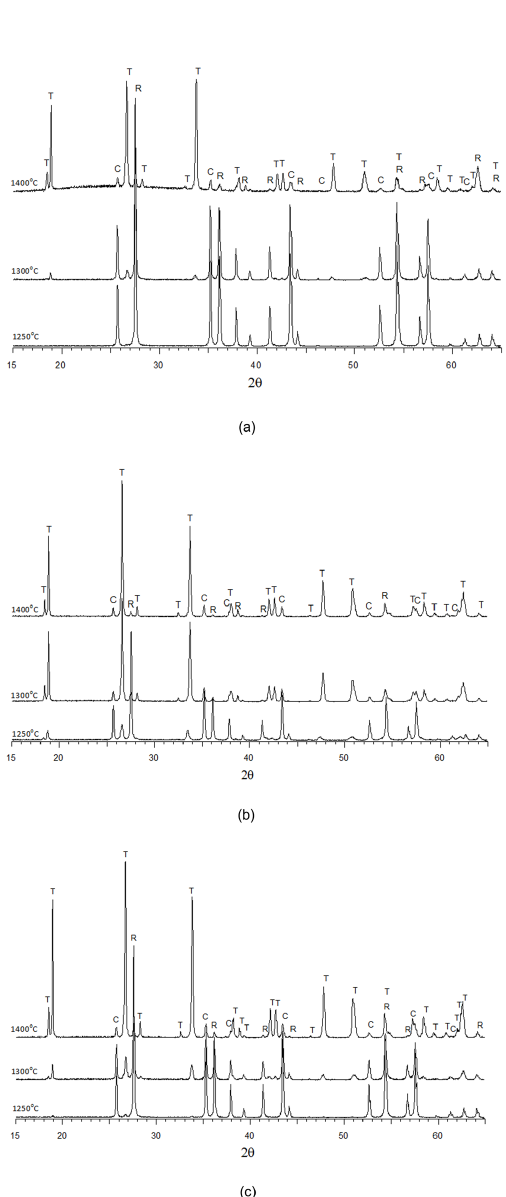
Figure 2. X-ray powder diffraction (XRPD) spectra taken from samples obtained by heat treatments at 1250, 1300 and 1400 for 1 hour. (a) ATP, (b) AT100M and (c) AT100S. T is aluminum titanate, C is α-alumina and R is